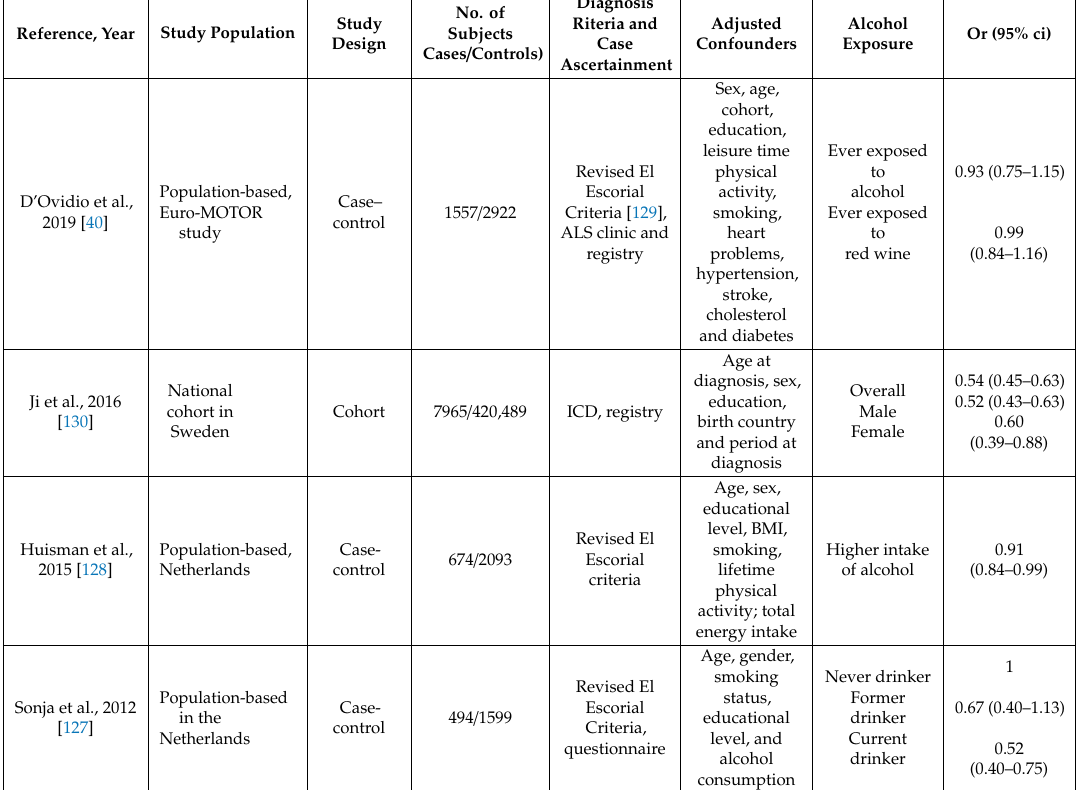
Table 4. Evidence-based studies on the relationship between alcohol intake and